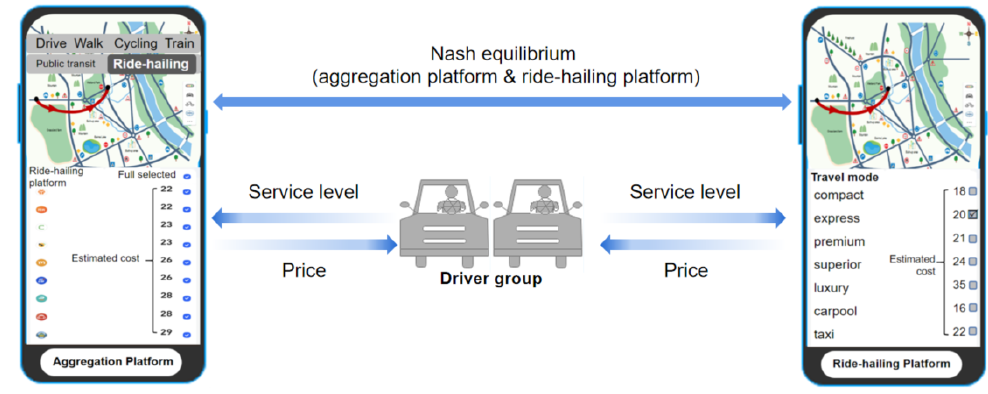
Figure 4. Structure of Model